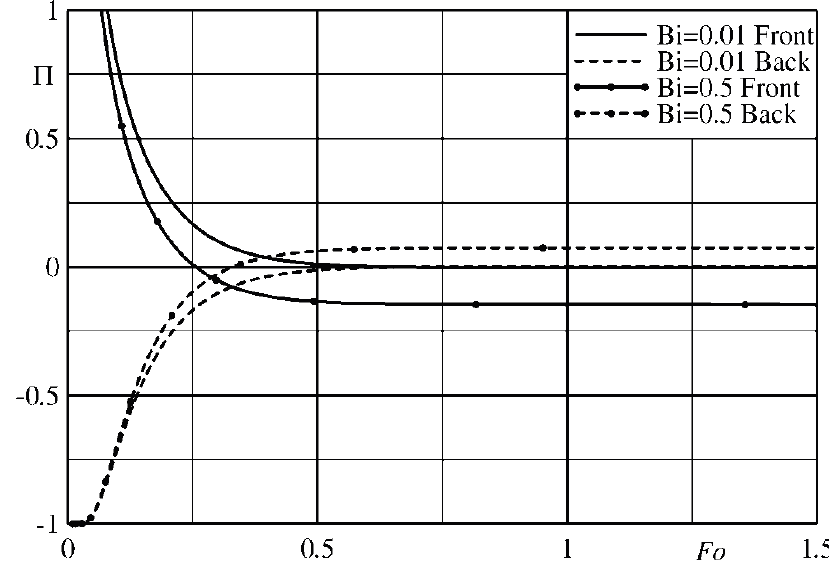
Figure 12. Error in the evaluation of the derivative of the mean slab temperature. Adapted from